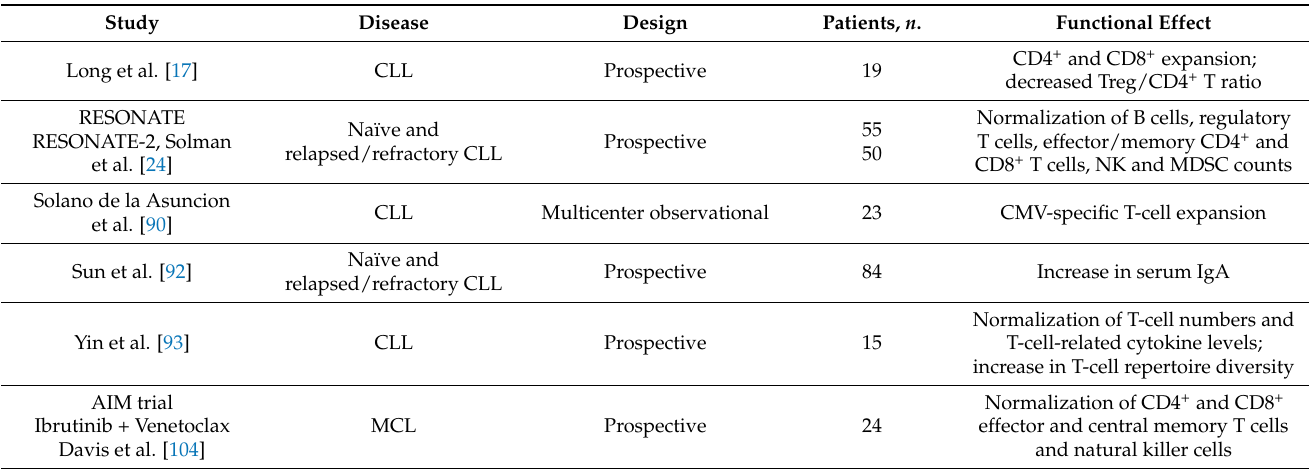
Table 1. Selected studies on the effects of ibrutinib on the recovery of immune